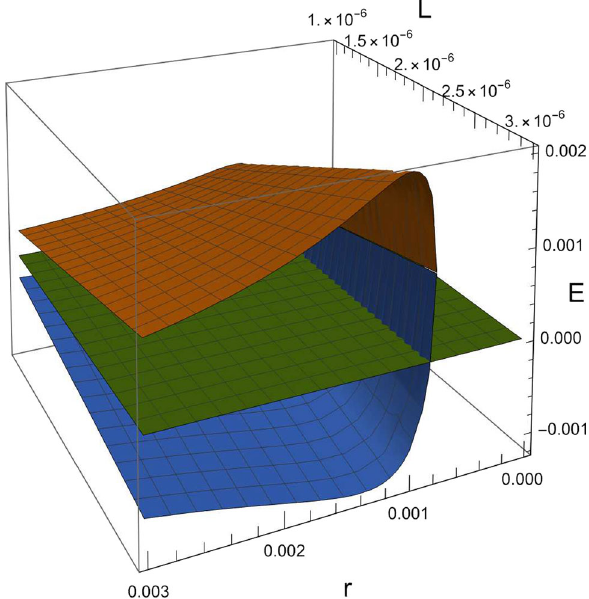
Fig. 1 Energy as the function of r and L . It indicates that the screen- ing of Hawking radiation with certain values of energy and angular momentum between blue and orange